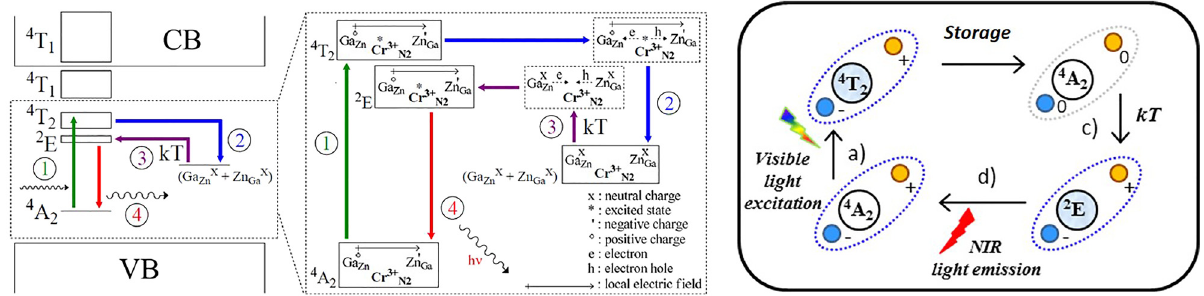
Figure 6: Mechanism of charge trapping and detrapping after a visible excitation leading to long-lasting phosphorescence in ZGO:Cr. Reproduced with permissions from [14,